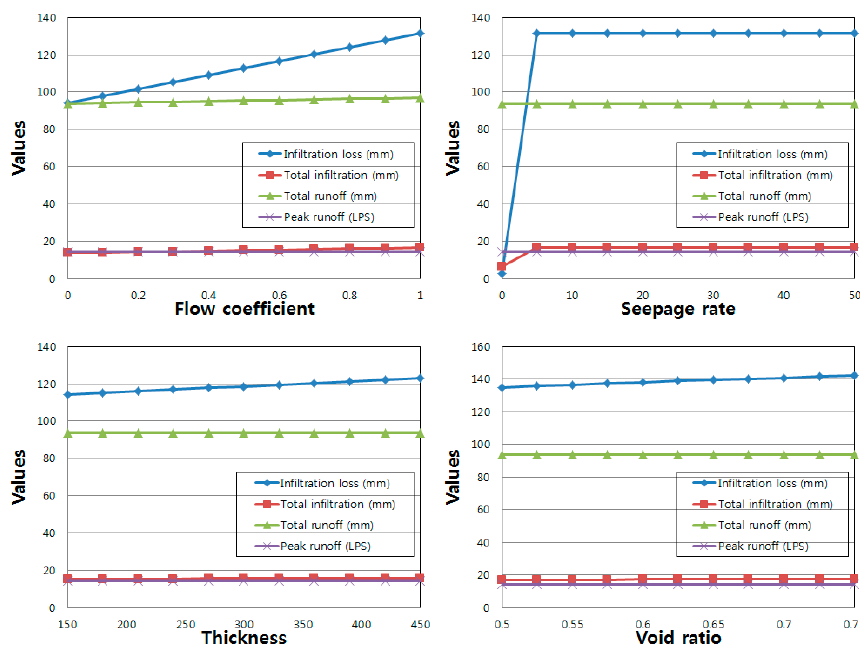
Figure 3. Sensitivity analysis of the sensitive design parameters.